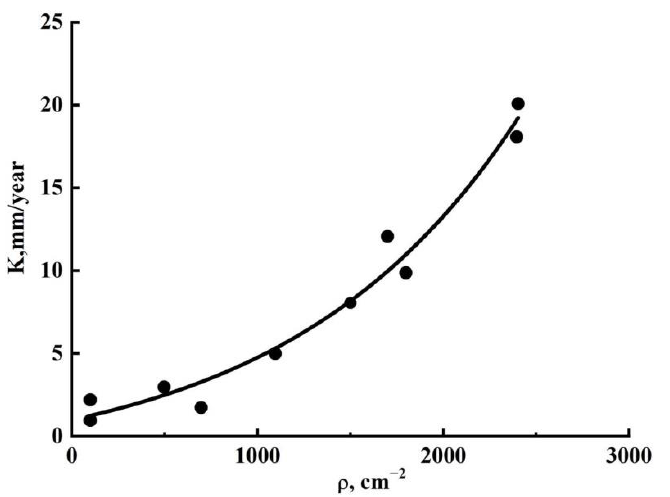
Figure 1. Relationship between corrosion rate and density of corrosive nonmetallic inclusion [20]. Reproduced with permission of Springer, copyright